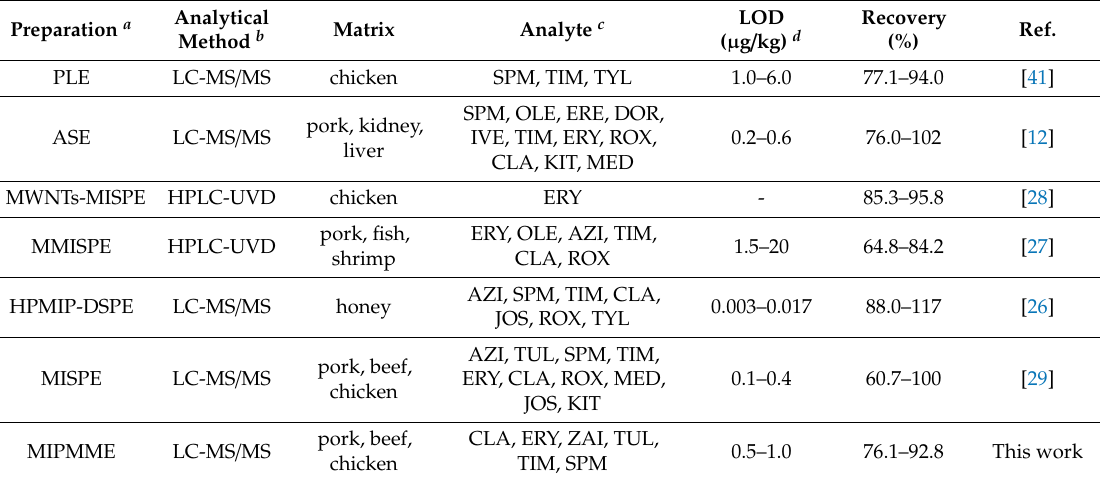
Table 3. Comparison of the method developed with other reported